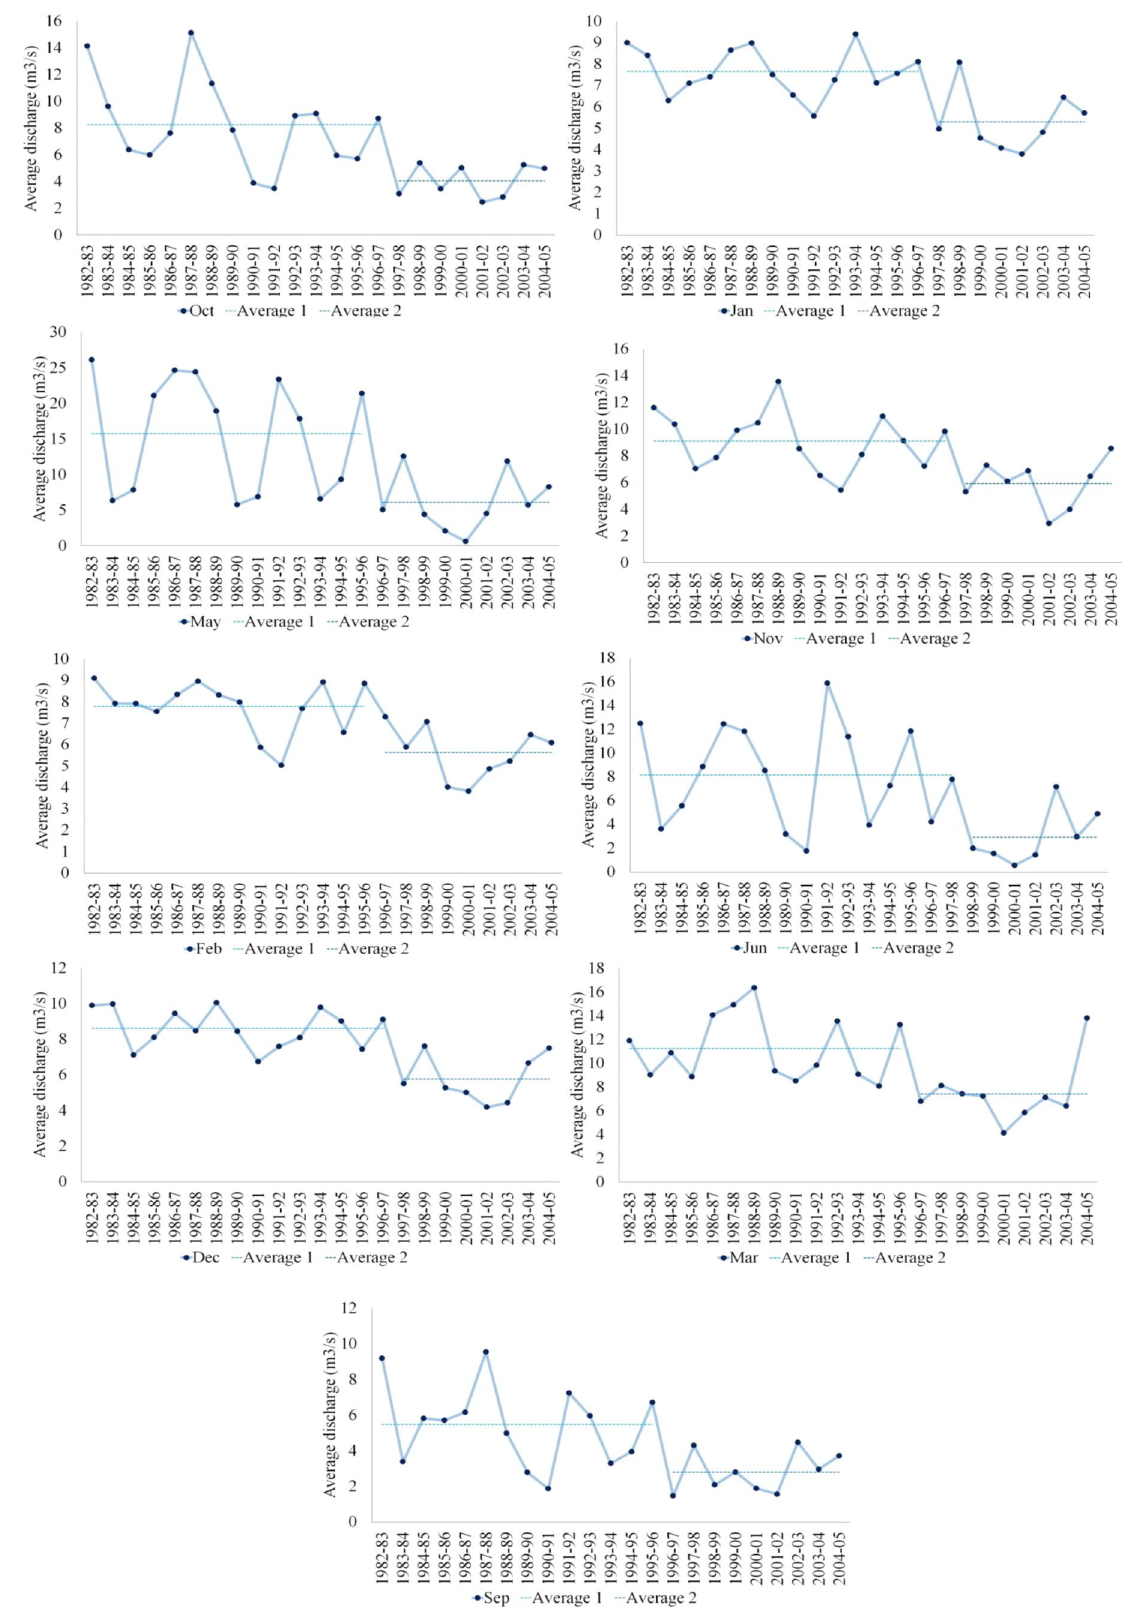
Fig. 10 Homogeneity test for the long-term mean streamflow in the baseline period